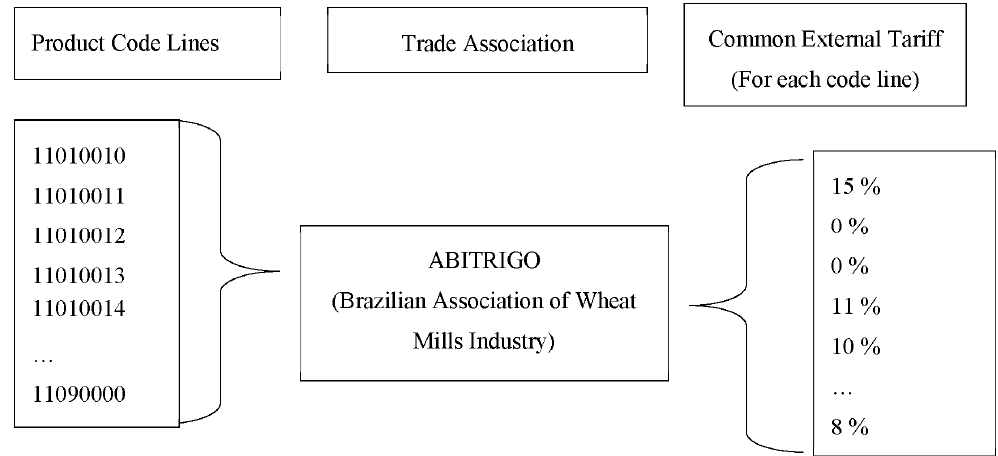
Figure 4. Method used for the selection of key sectors and their corresponding business associations.